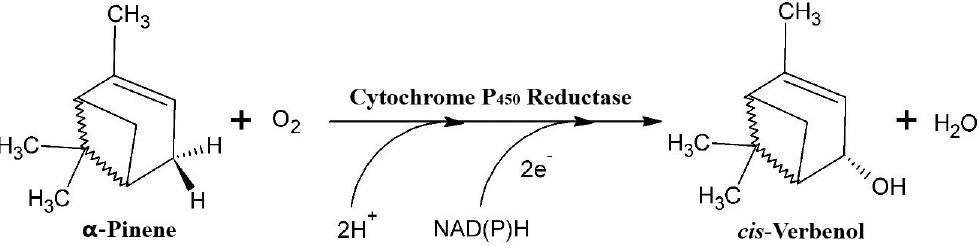
Figure 2. The hydroxylation of α -pinene via the P450 monooxygenase / reductase system (adapted from Krings [57]).